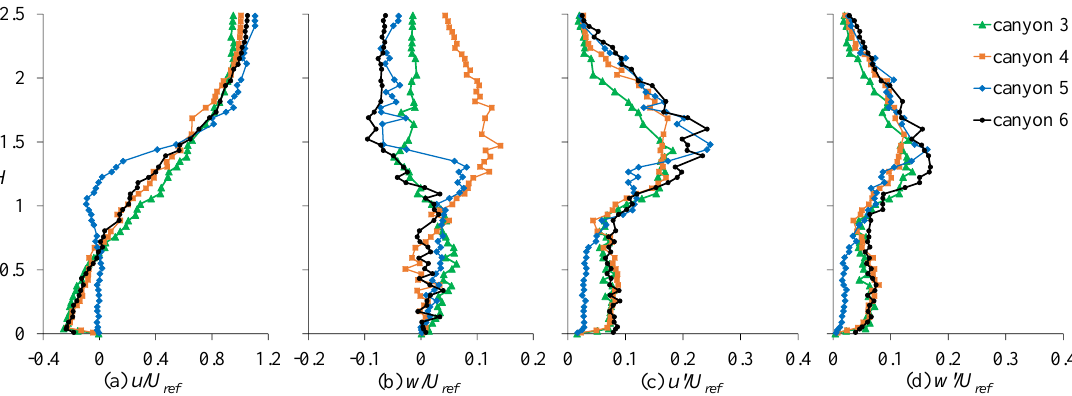
Figure 8. Normalized middle-line velocity profiles of canyons 3–6 with a step-up canyon 4 and a step-down canyon 5. ( a ) mean stream-wise velocity, ( b ) mean vertical velocity, ( c ) stream-wise velocity fluctuation, and ( d ) vertical velocity